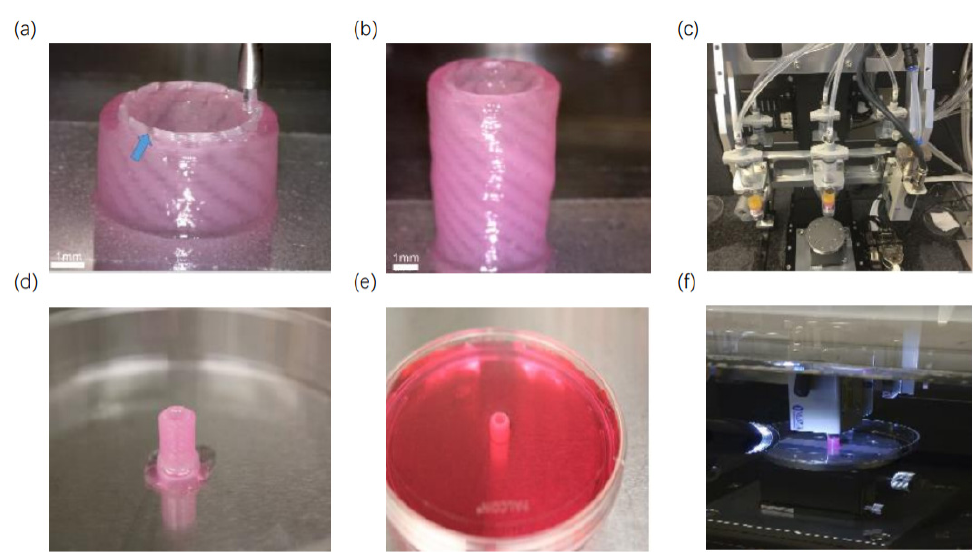
Figure 5. Three-dimensional bio-printing process of rabbit urethra: ( a ) 3D bioprinting using polymers and cell-laden hydrogel; ( b ) 3D-bioprinted rabbit urethra model; ( c ) The 3D bioprinting of scaffold part with polymer nozzle; ( d ) The hydrogel in the urethra model is being cross-linked; ( e ) The urethra model in culture medium; ( f ) The 3D bioprinter with two syringes. Reprinted with permission from ref. [91].